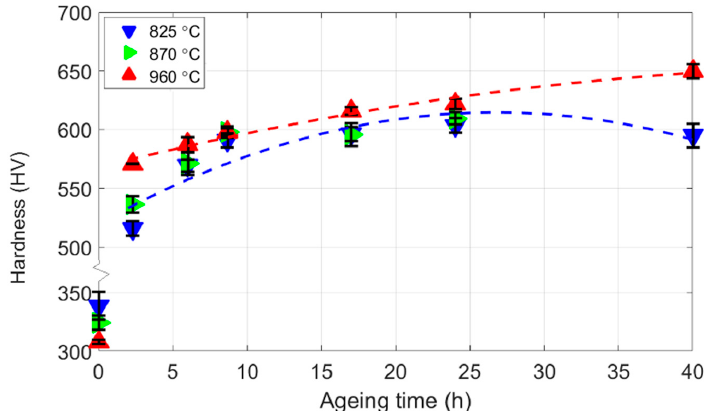
Figure 8. The change in Vickers hardness values with ageing time at 540 °C for the different austenitisation temperatures. The error bars show the standard deviation of the hardness measurements.